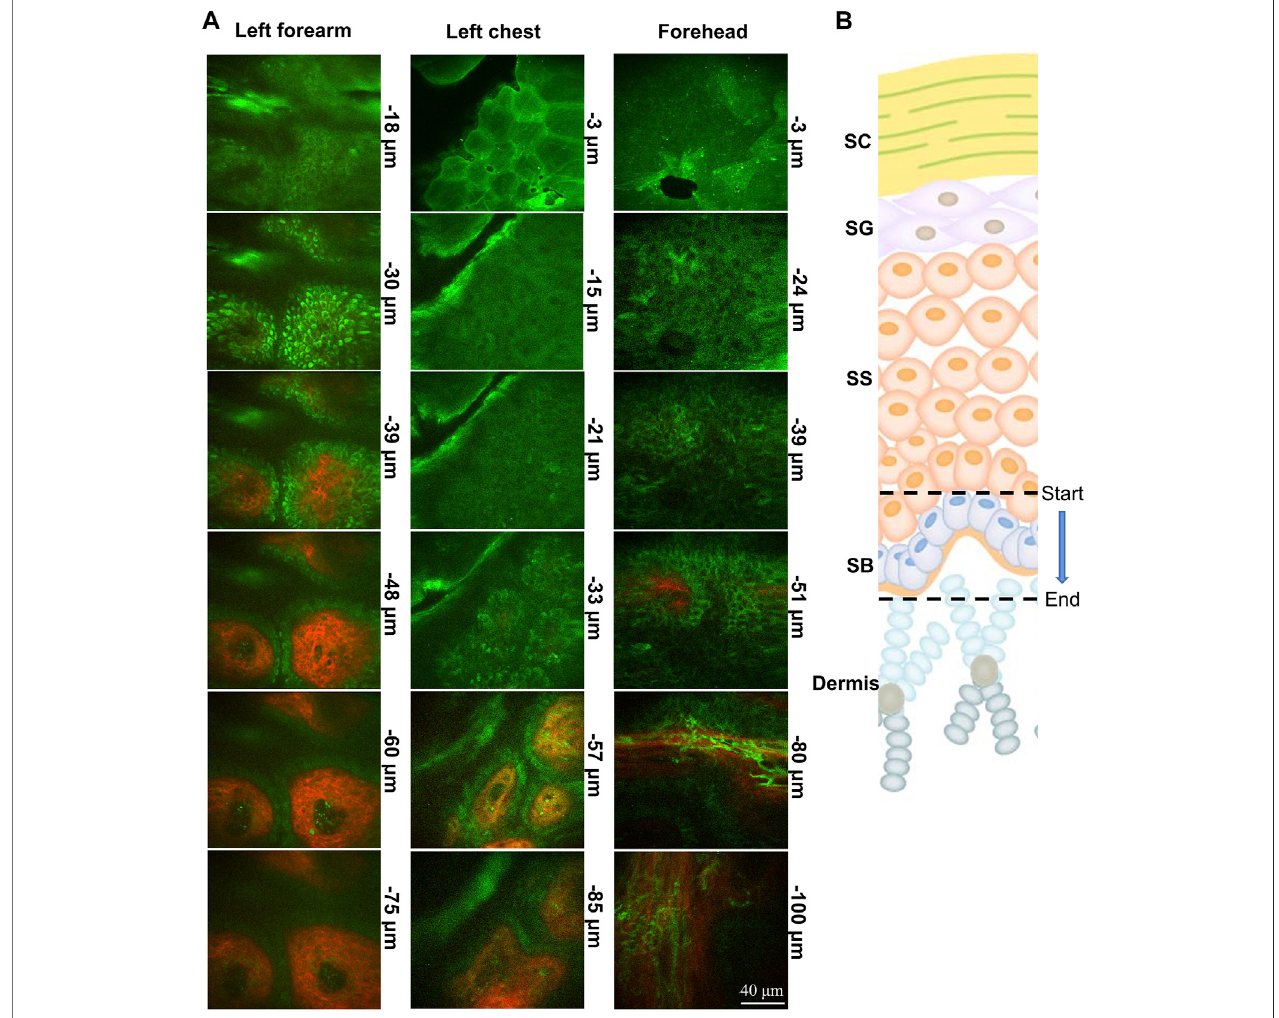
FIGURE 2 | Portable handheld two-photon microscope imaging of a skin structure. (A,B) Image of the clinical device portable two-photon microscope to perform non-invasive, label-free, rapid in vivo histology. Photograph of indicated parts of the body coupled to the probe of portable two-photon microscope imaging system during imaging. TPEF (green) and SHG (red) images of skin obtained from different depths below the skin surface. SC, stratum corneum; SG, stratum granulosum; SS, stratum spinosum; SB, stratum basale.